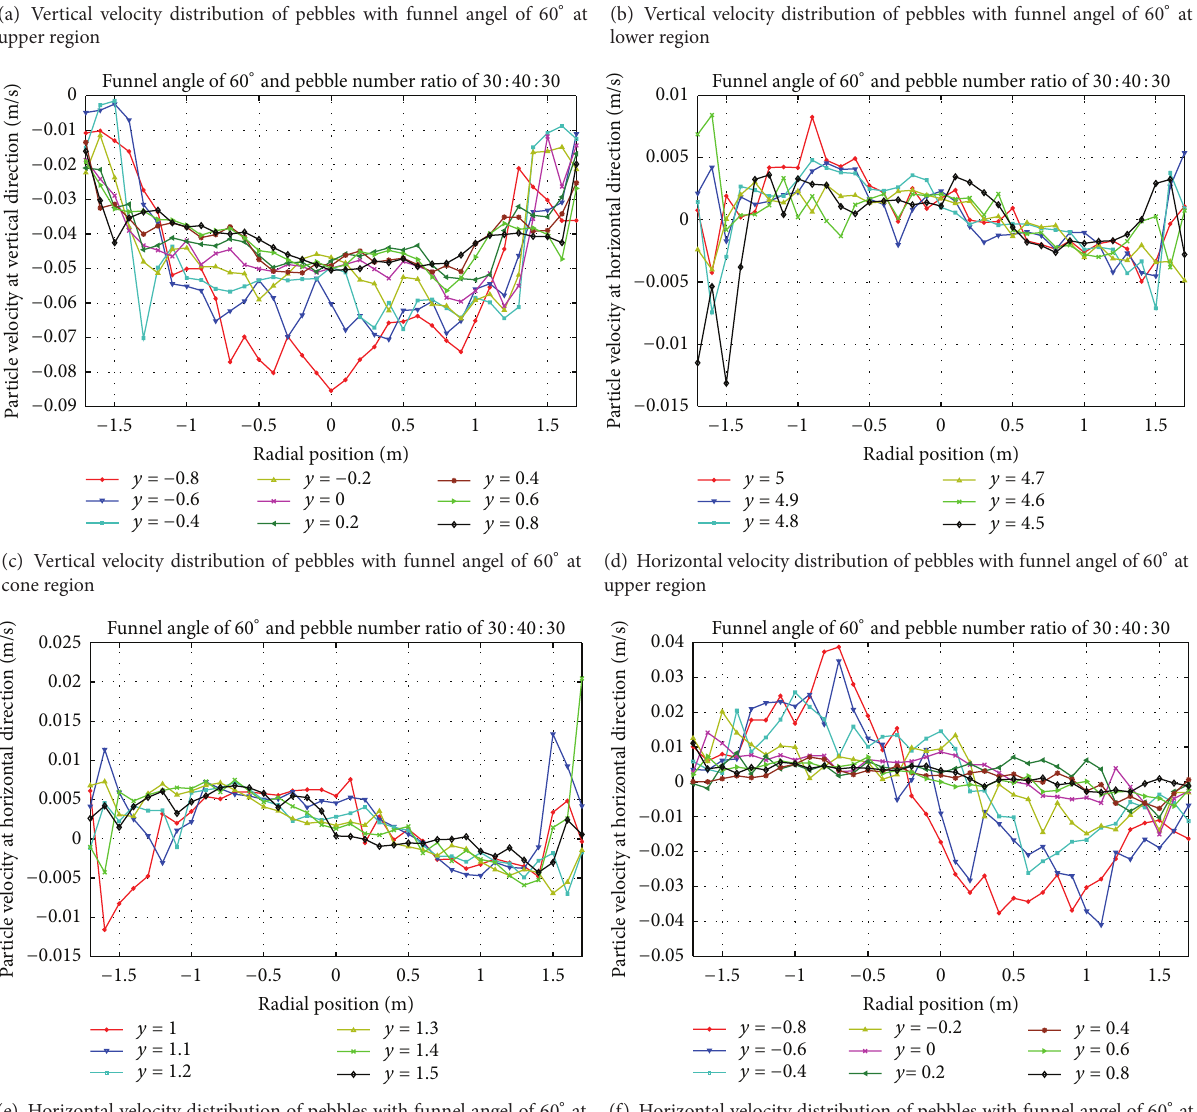
(a) Vertical velocity distribution of pebbles with funnel angel of 60 ∘ at upper region Funnel angle of 60 ∘ and pebble number ratio of 30 : 40 : 30